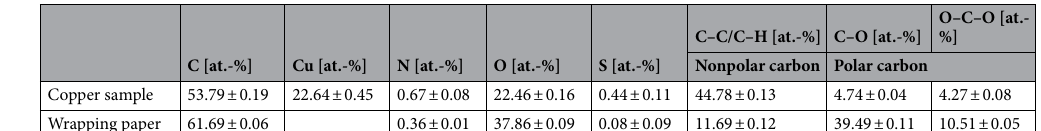
C [at.-%] Cu [at.-%] N [at.-%] O [at.-%] S